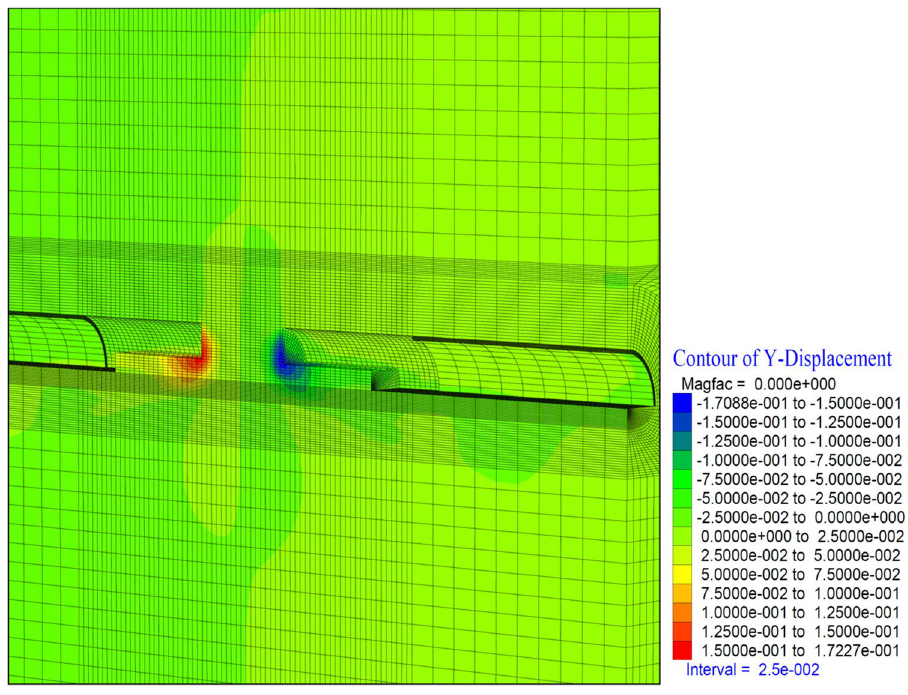
Figure 21. Y displacement in stage 26.